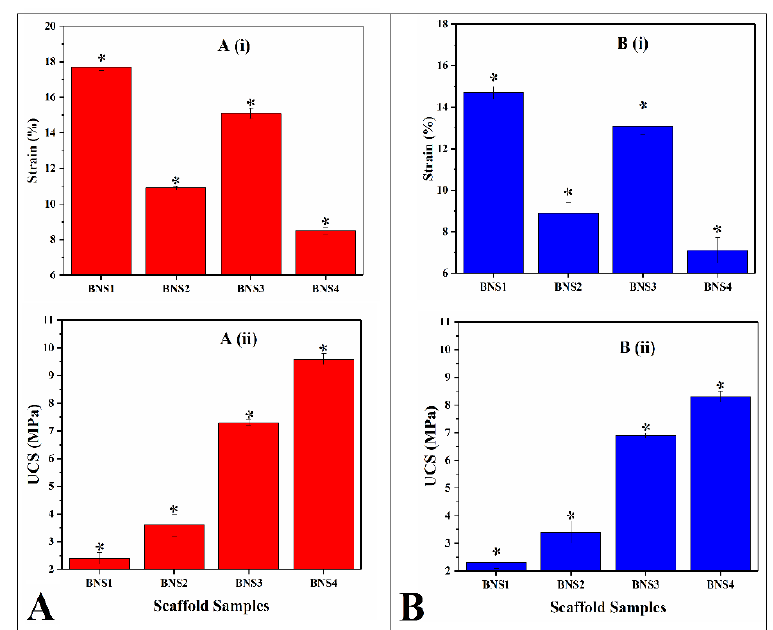
Figure 5. Mechanical behavior of all scaffold samples in dry form A and wet form B at room temperature: ( A , B ) (i) percentage of strain (strain %) of all BNS samples. ( A , B ) (ii) unconfined compression strength testing (UTS) of all BNS samples.